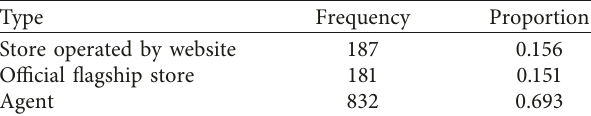
Table 3: Characteristics of business type sampled online. Type Frequency Proportion Store operated by